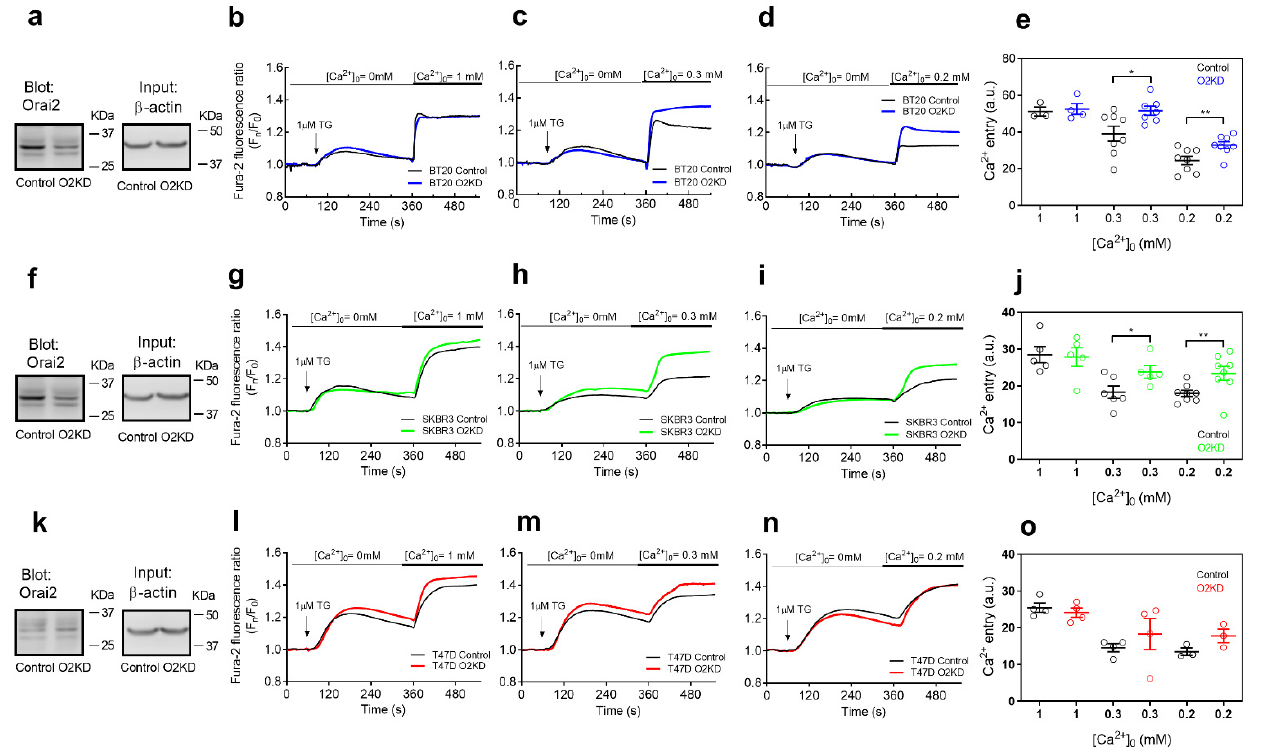
Figure 2. The functional role of Orai2 in store-operated Ca 2+ entry in breast cancer. BT20 ( a ), SKBR3 ( f ) and T47D ( k ) cells were transfected with esiOrai2 (O2KD) or non-specific siRNA (Control; C). Forty-eight hours later cells were lysed and whole cell lysates were subjected to 10% SDS-PAGE and Western blotting with the anti-Orai2 antibody, as described in Section 4. Membranes were reprobed with anti- β -actin antibody for protein loading control. Molecular masses indicated on the right were determined using molecular-mass markers run in the same gel. Blots are representative of four to seven separate experiments. ( b – o ) BT20 ( b – d ), SKBR3 ( g – i ) and T47D ( l – n ) cells were transfected with esiOrai2 (O2KD) or non-specific siRNA (Control). Forty-eight hours later cells were loaded with Fura-2 and were continuously superfused with Ca 2+ -free HBSS or HBSS containing 1 mM, 0.3 mM or 0.2 mM Ca 2+ , as indicated. Cells were stimulated with 1 μ M TG at 1 min (as indicated). ( e , j , o ) Quantification of TG-induced Ca 2+ influx in BT20 ( e ), SKBR3 ( j ) and T47D ( o ) cells under the different experimental conditions ( n = 3–8; n-values correspond to independent experiments). Scatter plots are represented as mean ± SEM and were statistically analyzed using Student´s t -test (* p < 0.05 and ** p < 0.01).